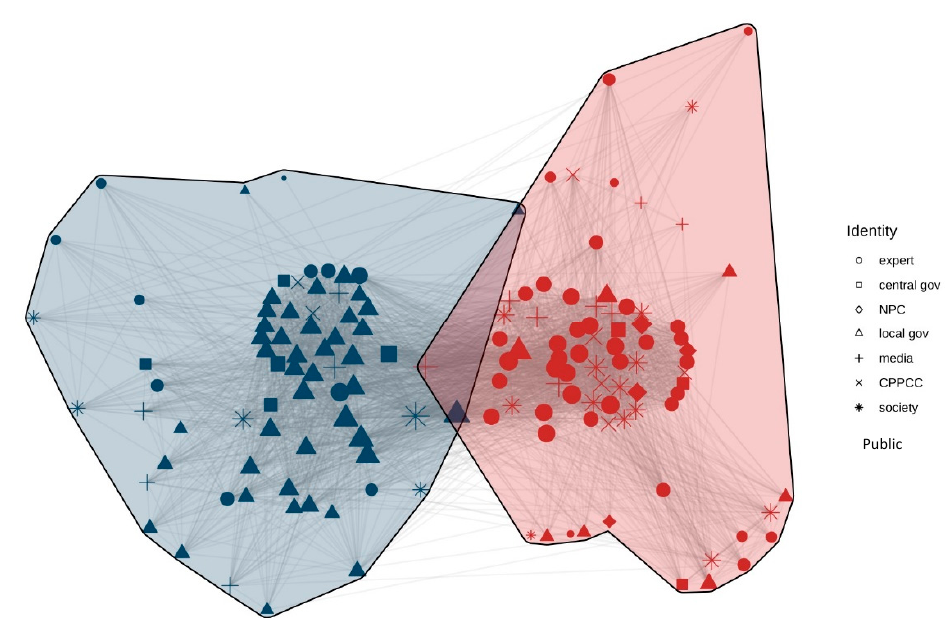
Figure 5. Discourse network visualisation (2010–2012). Note: NPC = National People’s Congress.